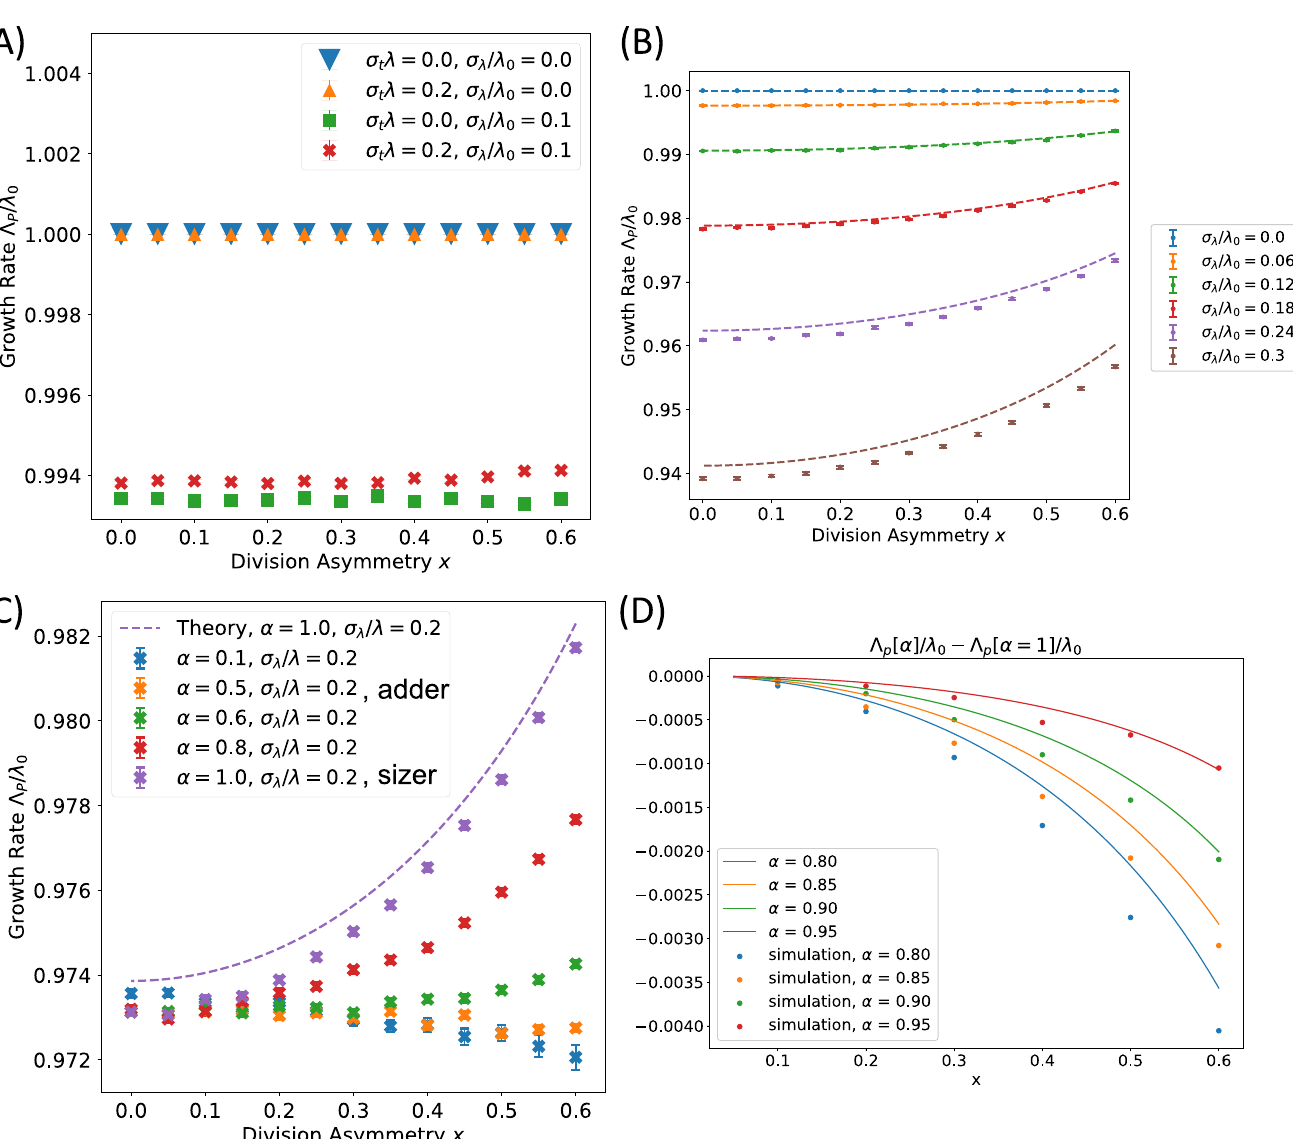
Fig 2. The population growth rate Λ is dependent on noise in single cell growth rate σ λ , the division asymmetry x and the size control strategy α for P asymmetrically dividing cells. (A) Λ P = λ exactly in the absence of noise in λ for cells that display size control, regardless of time-additive noise in generation times or division asymmetry. Coarse-grained noise in λ decreases Λ . Plot is shown for adder cells with α = 1/2. (B) Comparison of Eq 5 with simulations for a sizer model ( α = P 1) shows good agreement for small σ λ , with σ t = 0. (C) Λ P plotted for a range of size control strategies α with fixed σ λ . Size control strategies weaker than an adder do not display any benefit in Λ from dividing asymmetrically. σ λ / λ 0 = 0.2, σ = 0. (D) Deviation from a sizer causes a relative decrease in Λ P t between Eqs 43 in S1 Appendix for Λ P ( α ) and 5 for Λ P ( α = 1) is plotted against x for deviations from α = 1. Parameters are listed in the figure legend, with σ λ / λ 0 = 0.2, and σ t = 0. Data points correspond to simulations, while lines represent theoretical predictions. Error bars in (A-C) show the standard error of the mean.